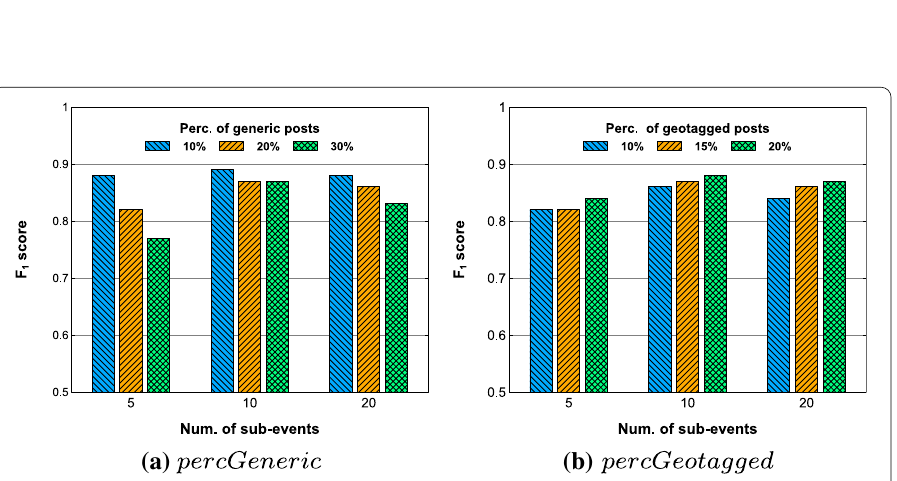
Fig. 6 F1-score for different values of the percentages of generic posts ( percGeneric ) and geotagged posts ( percGeotagged ) in the data